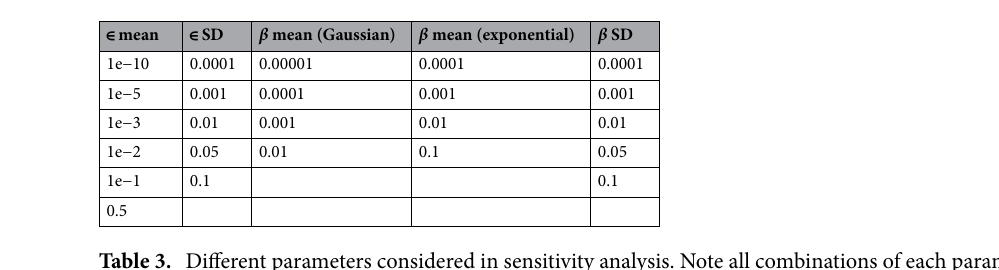
Table 3. Different parameters considered in sensitivity analysis. Note all combinations of each parameter were